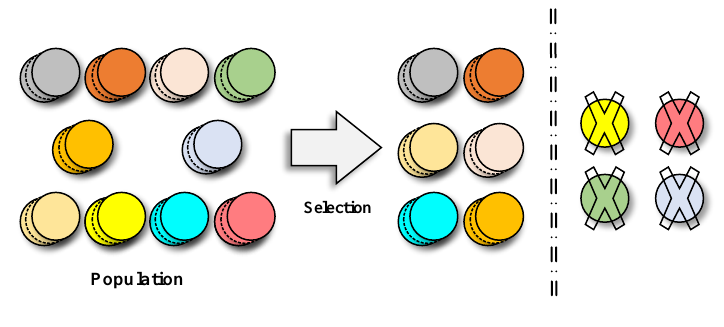
Figure 2. GA selection operation.